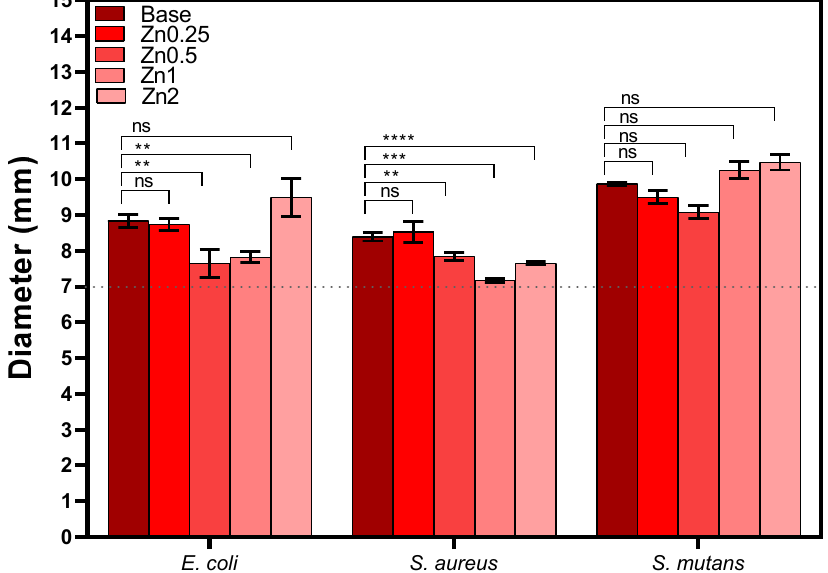
Figure 8. Values of the inhibition halo diameters of all samples against Gram-negative ( E. coli ) and Gram-positive ( S. aureus and S. mutans ) bacteria after incubation for 24 h (ns: non significant; ** p ≤ 0.01; *** p ≤ 0.001; **** p ≤